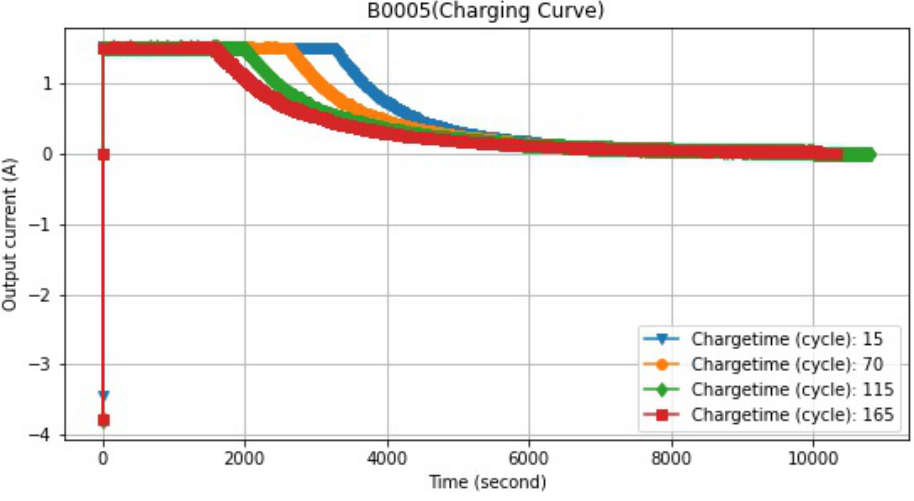
Figure 5. Currents during different